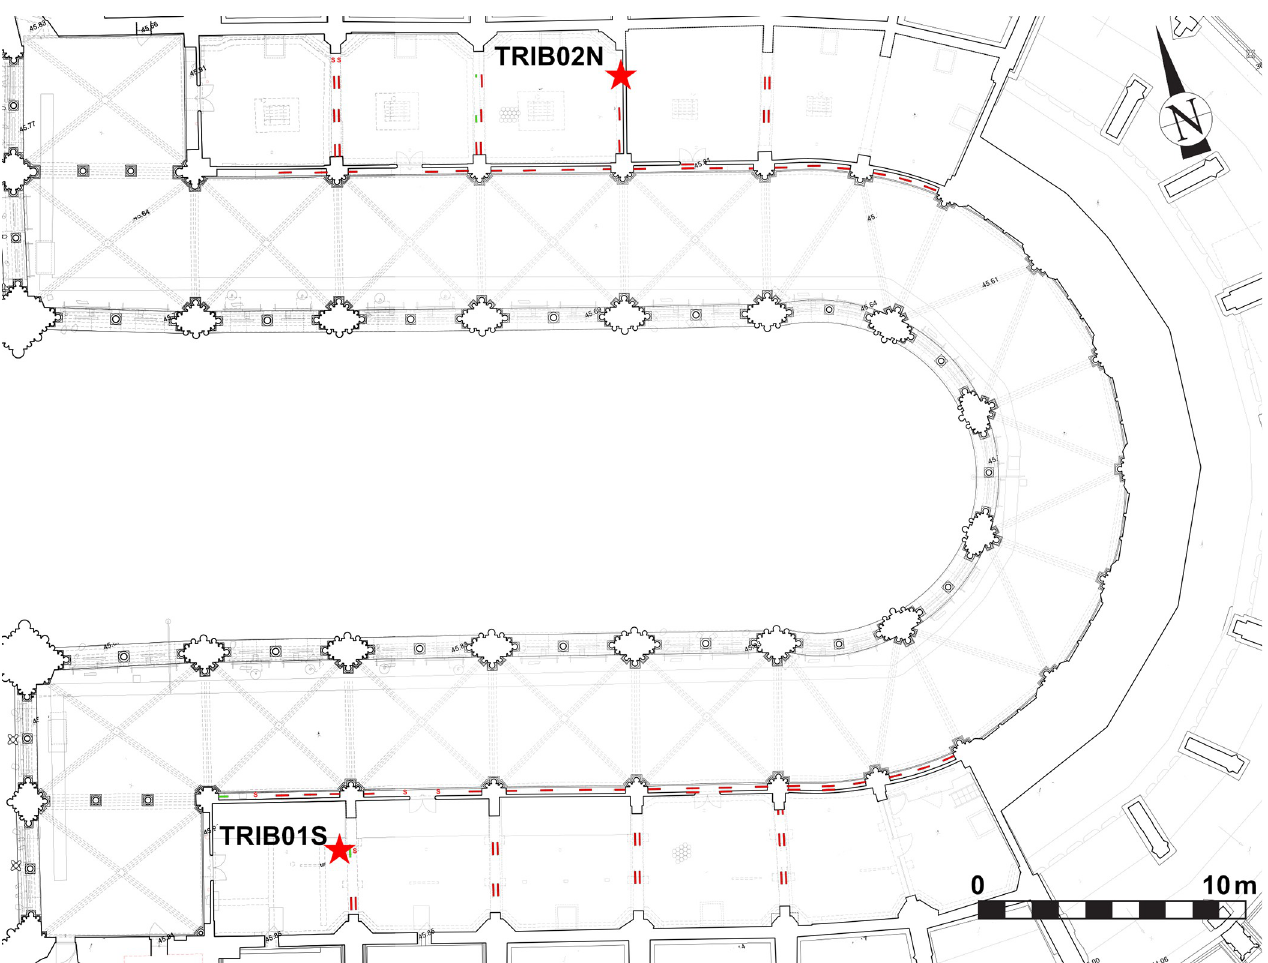
Fig 2. Map of the tribunes of the choir, showing the location of the staples (red lines) and the sampling (red stars).